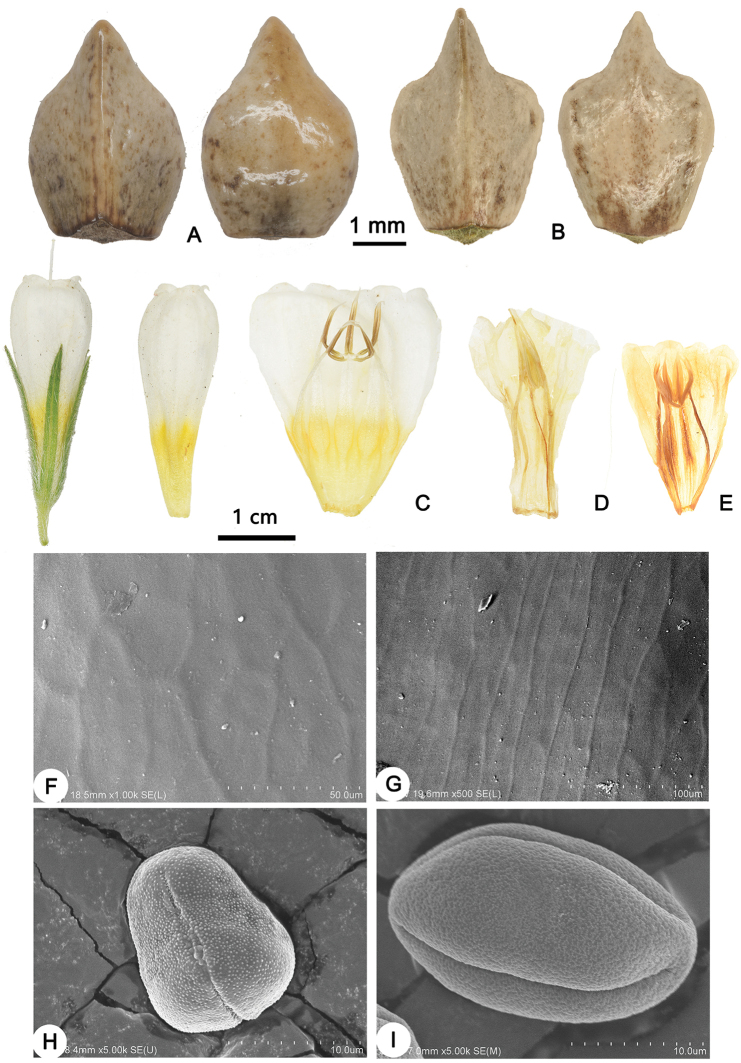
Characters comparison of O.
fuyunensis and related species A nutlets of O.
gmelinii (in adaxial and abaxial view) B nutlets of O.
fuyunensis (in adaxial and abaxial view) C flowers of O.
fuyunensisD corolla of O.
gmeliniiE corolla of O.
simplicissimaF scanning electron micrograph of nutlets of O.
gmeliniiG scanning electron micrograph of nutlets of O.
fuyunensisH scanning electron micrograph of pollens of O.
gmeliniiI scanning electron micrograph of pollen of O.
fuyunensis. Photo by Yi He.